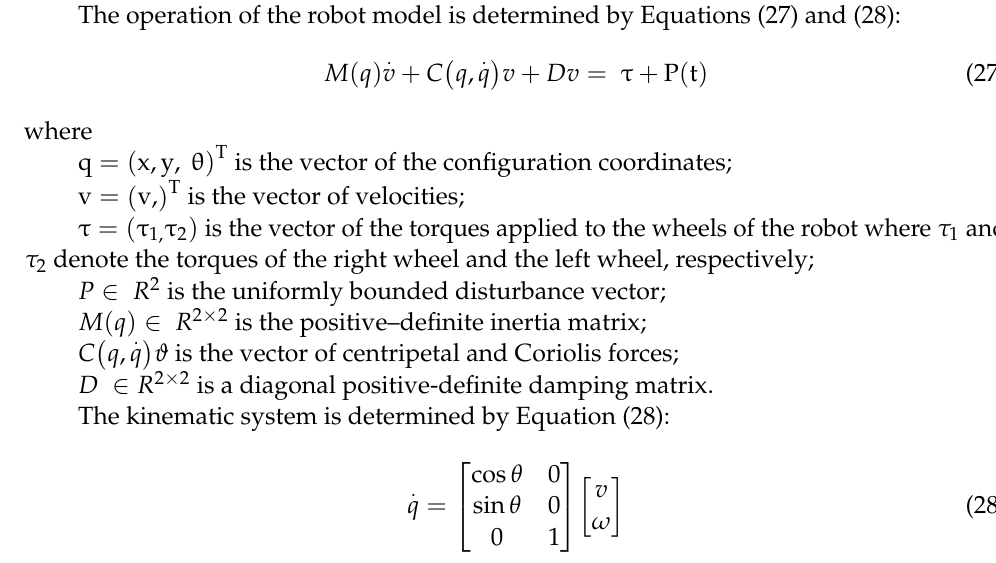
Figure 3. Illustration of the mobile robot model.